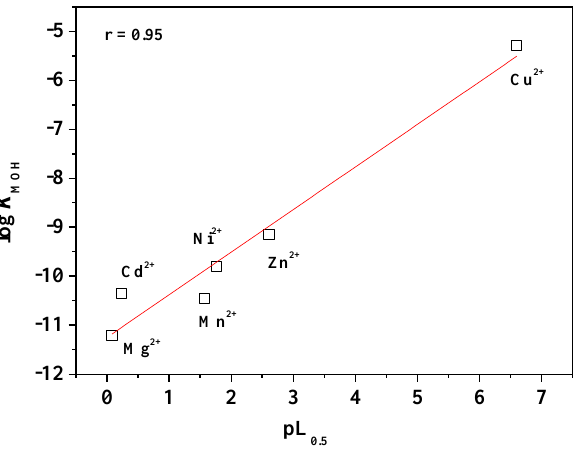
Figure 16. Relationship between the value log K MOH value of some M 2+ metal ions vs. pL 0.5 calculated at I = 0.15 mol dm − 3 , T = 298.15 K and pH = 7.4. Similar results can be obtained from the comparison of the pL 0.5 values vs. the I = 0.15 mol dm − 3 and T = 298.15 K. Data for Mn 2+ and (CH 3 CH 2 ) 2 Sn 2+ (DET) reported in linear relationship (r = 0.90) was